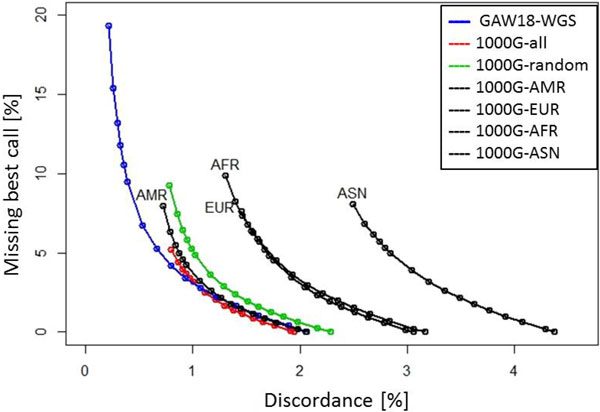
Discordance percentages versus no-call percentages for different reference panels. Each line on the plot is generated by repeating calculations of 2 percentages for calling thresholds, ranging from 0.33 to 0.99 for a reference panel.